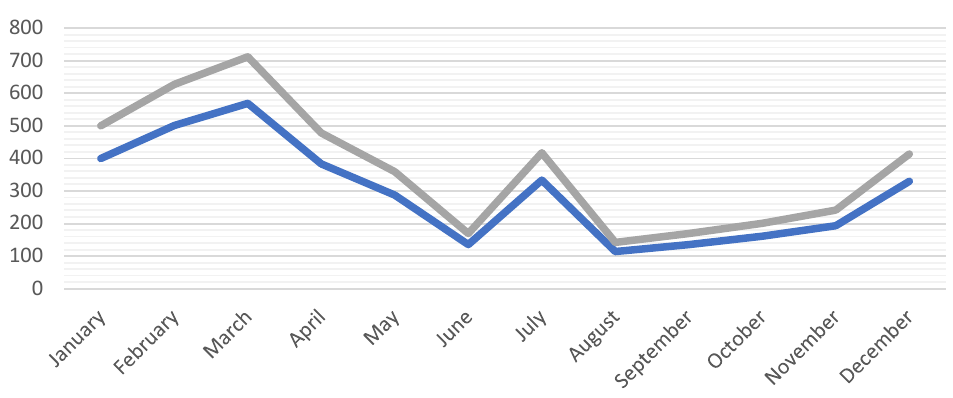
Figure 14. GtoC Comparing Two Scenarios .